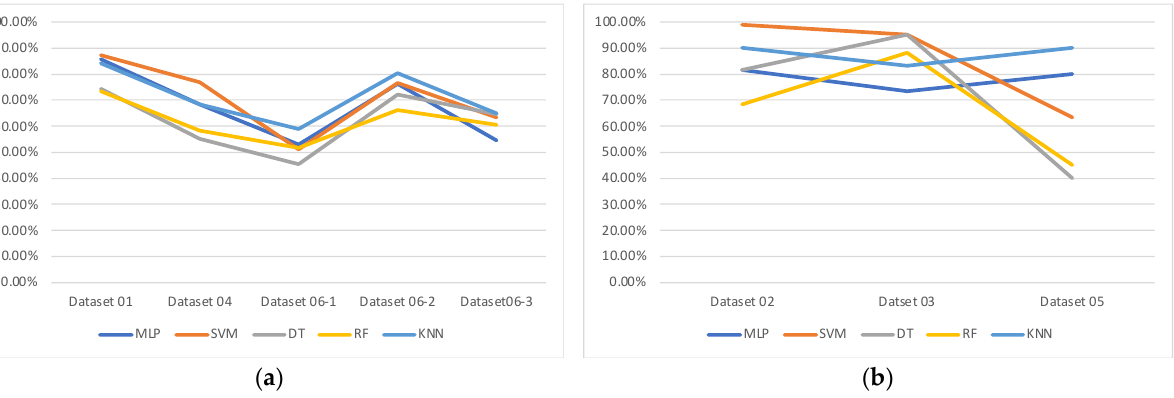
Figure 14. Results of the tested classification algorithms reorganized into miRNA and mRNA data; ( a ) accuracies for miRNA datasets; ( b ) accuracies for mRNA datasets.